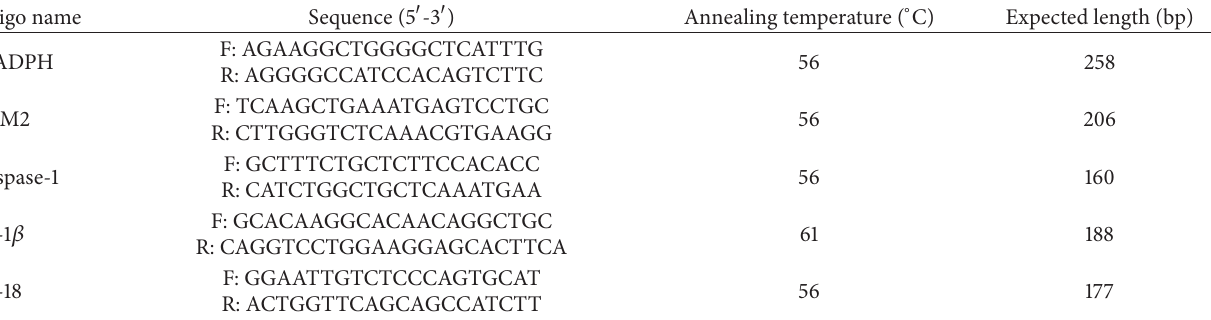
Table 1: Primer sets and controls used to detect AIM2, caspase-1, IL-1 𝛽 , and IL-18.